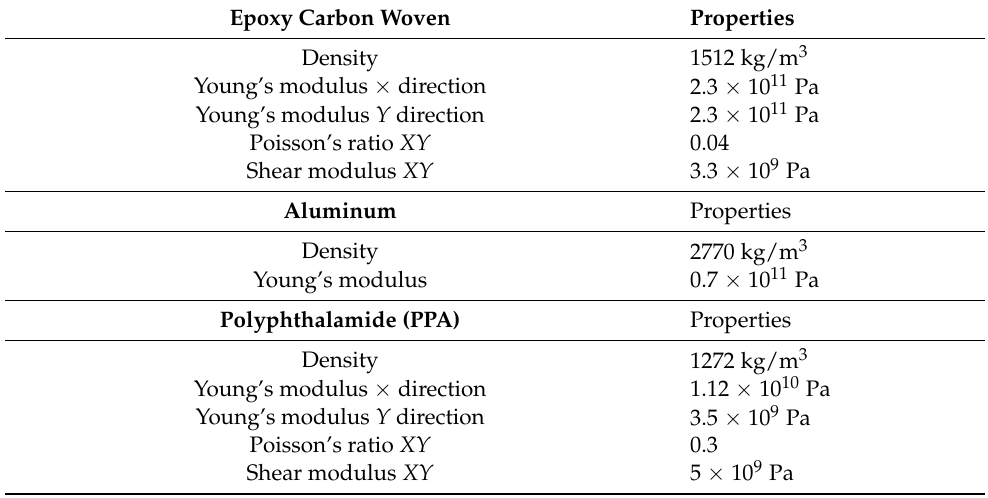
Table 1. Properties of the